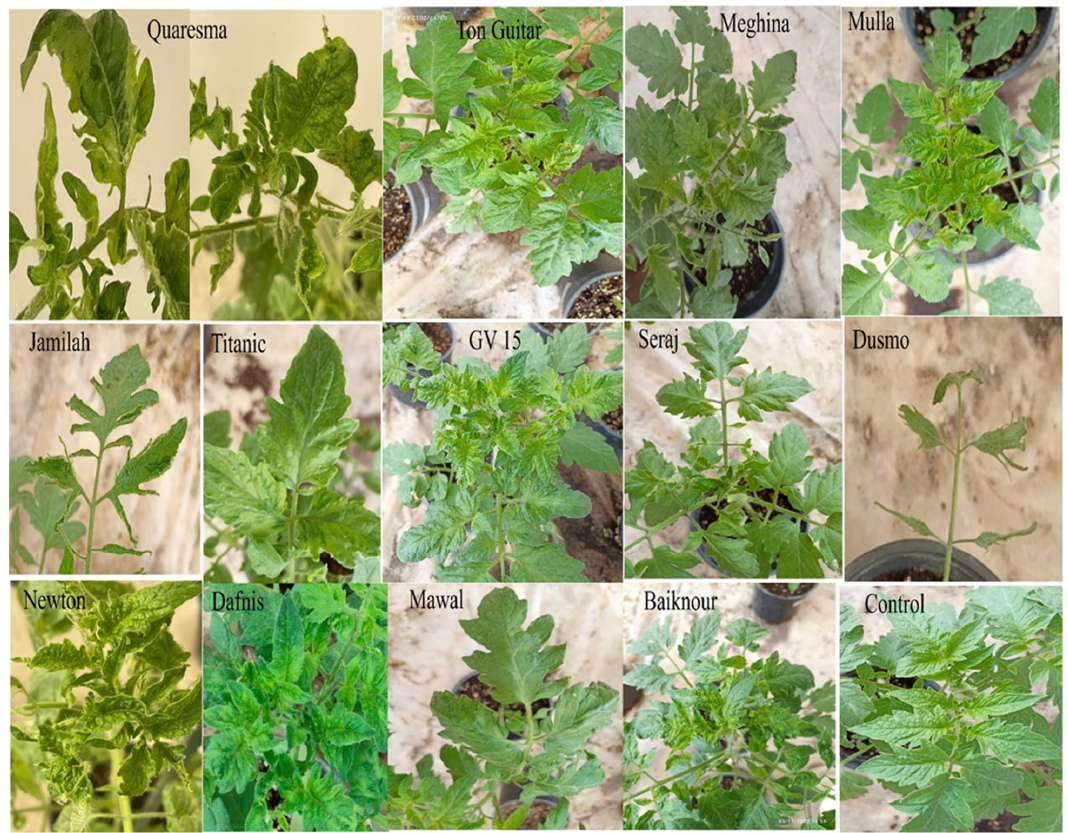
Figure 5. Symptoms on tomato cultivars inoculated by ToBRFV showing different symptoms on different cultivars. Table 4. Tomato plant symptoms observed on different tomato cultivars inoculated with the Saudi Arabian isolate of ToBRFV, as well as DSI, symptoms severity rating, and RT-PCR results after three weeks after inoculation.